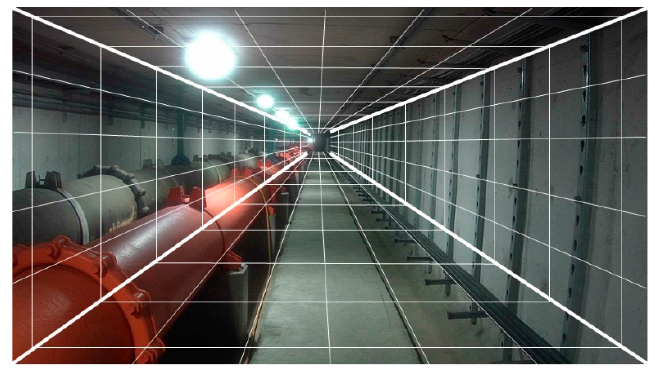
Figure 6. Estimated map of the standard grid for underground utility tunnels.